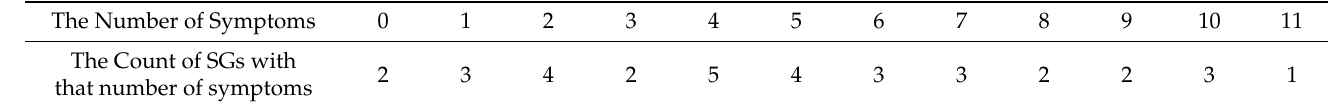
Table 1. Number of breakthrough cases; number of